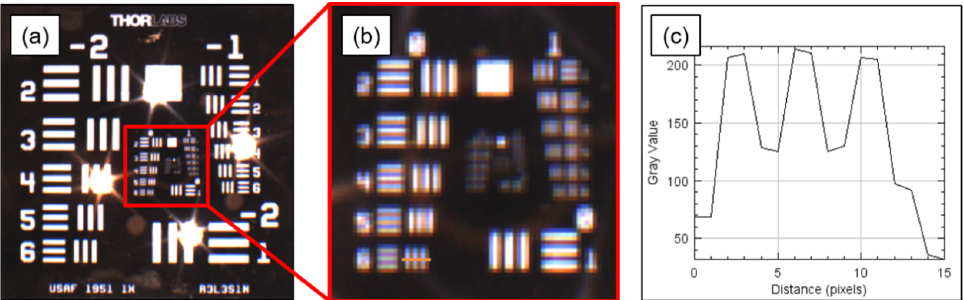
Figure 3. Spatial resolution test of the system. ( a ) Color image of USAF 1951 resolution target at 30 cm working distance. ( b ) Digitally magnified and cropped image of ( a ). ( c ) Line profile of element 6 on group 0 of the resolution target.